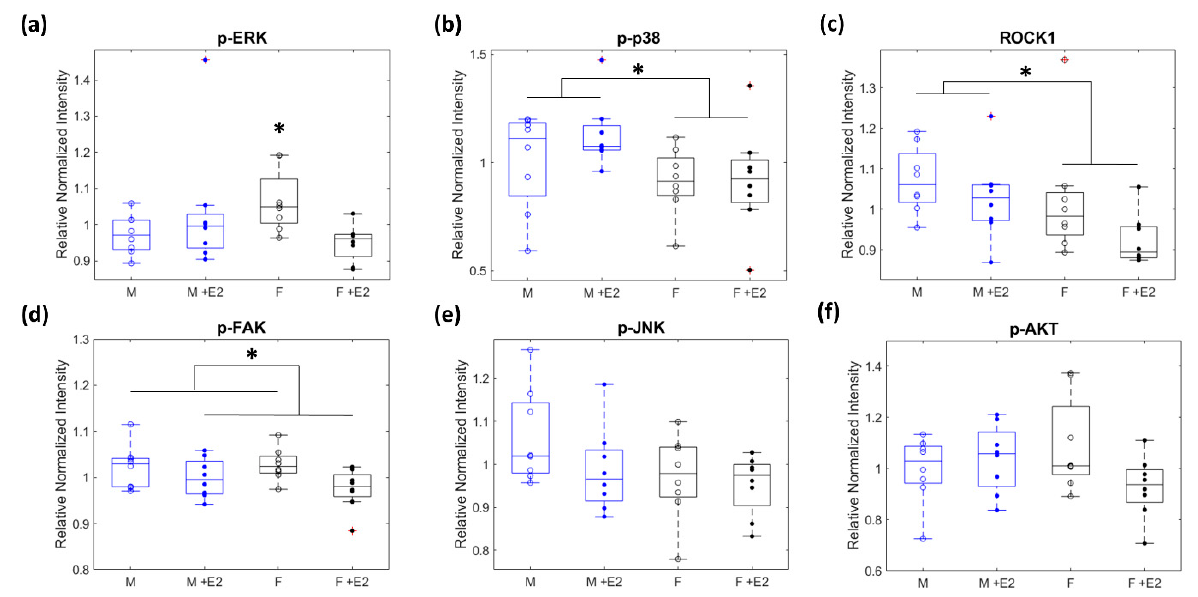
Figure 4. A two-way ANOVA was used to determine if there was any significant interaction ( α = 0.05) between sex (male = blue and female = black) and estrogen treatment (baseline = open dots to represent median of biological replicates and +E2 = closed dots) on the normalized median intensity of profibrotic proteins. p-ERK showed a significant interaction between sex and E2 treatment (* p < 0.05, ( a )). The median intensity of ROCK1 and p-p38 was significantly different due to biological sex (* p < 0.05, ( b , c )). E2 treatment caused a significant difference in median intensity for p-FAK (* p < 0.05, ( d )). No significant interactions between or within groups existed for p-JNK or p-AKT ( e , f